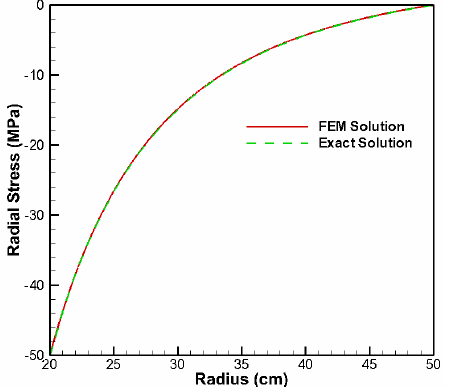
= 50 𝑀𝑃𝑎 Figure 20. Tangential stress under 𝑞 𝑖